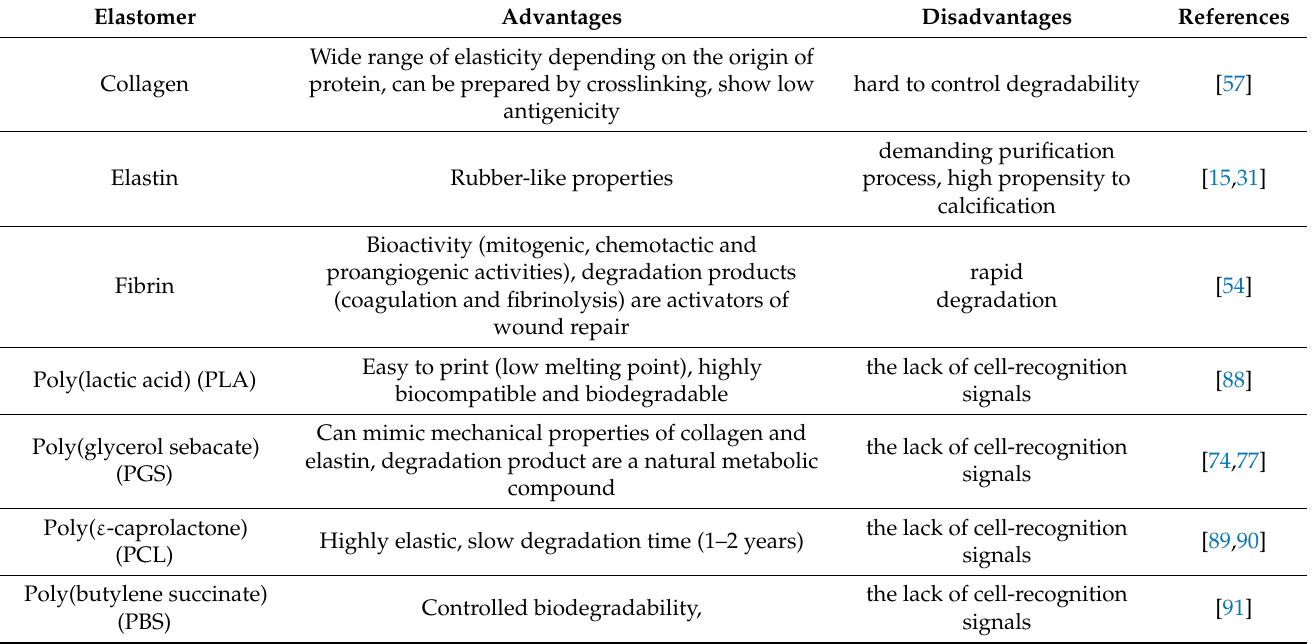
Table 3. Advantages and disadvantages of selected natural and synthetic